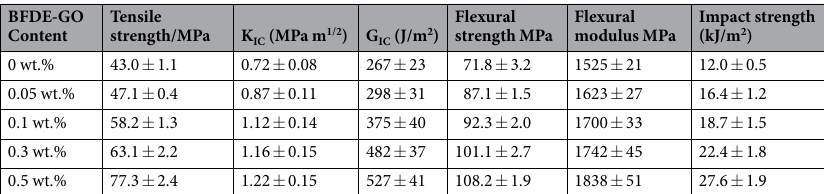
Table 1. Thermal and mechanical properties of bGO/BFDE